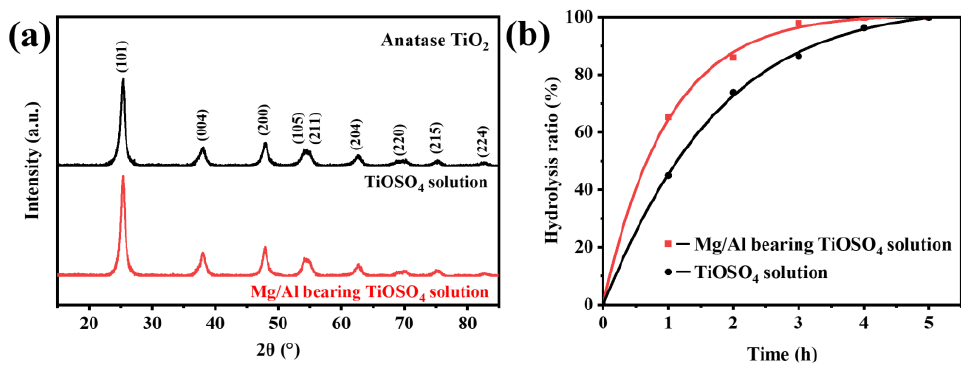
Figure 1. ( a ) XRD patterns of hydrated TiO 2 ; ( b ) Hydrolysis ratio